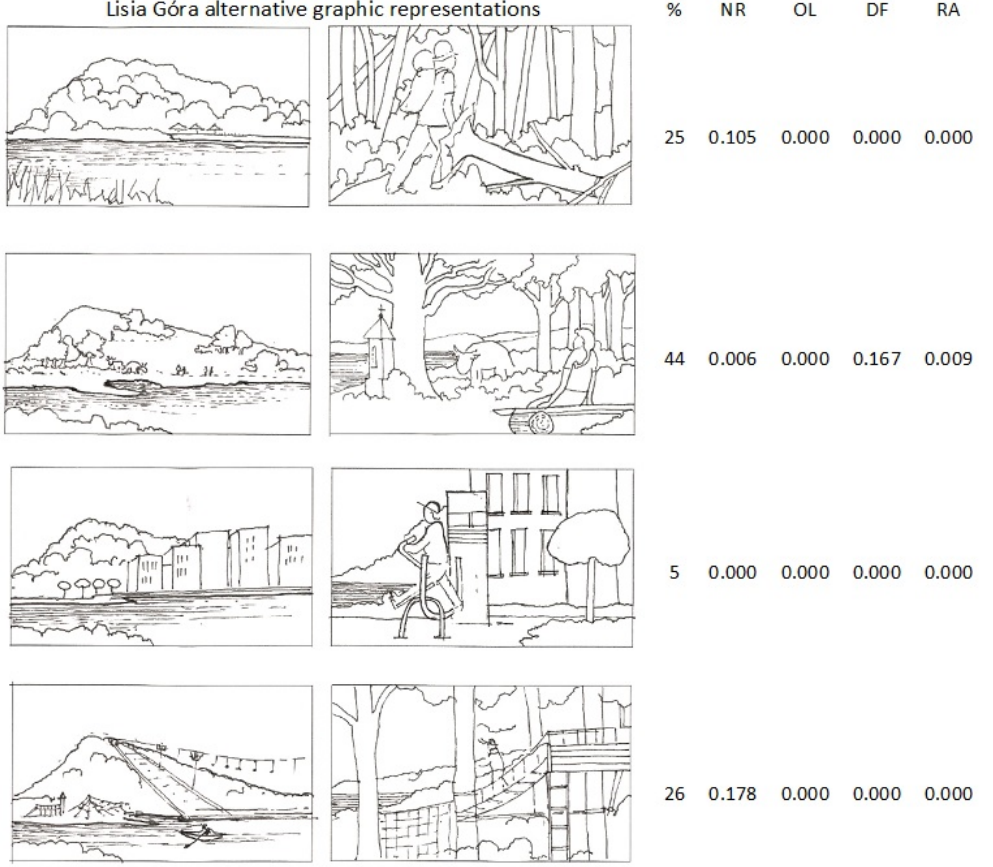
Figure 8. Relative distribution of the visitors’ (exclusive) percent preferences (%) referring to four alternative graphic representations of Lisia Góra; in four columns on the right: p values in Cochran Q test for differences between the preferences of visual and descriptive reserve’s scenarios; for NR, OL, DF, RA explanation see Table 2.